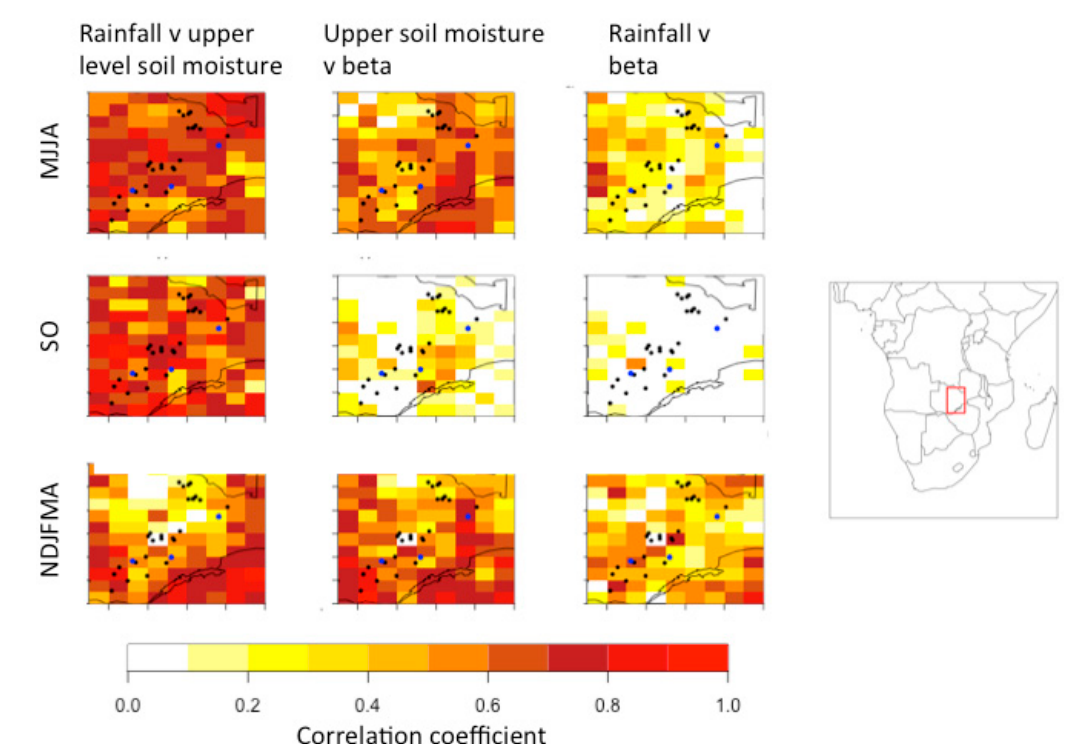
Figure 2. Correlation between rainfall and upper level soil moisture ( left ); upper level soil moisture and beta ( middle ); rainfall and beta ( right ) for (from top to bottom) May–August, September–October, November–April. Black circles are the localities for which loss data are available; blue circles represent the locations shown in Figures 3–5 (from west to east: Chikanta, Magoye, Makafu). The area encompassed in these plots is shown as a red box on the map of Africa, on the right. The rainfall in the figure is from an example TAMSAT ensemble member.